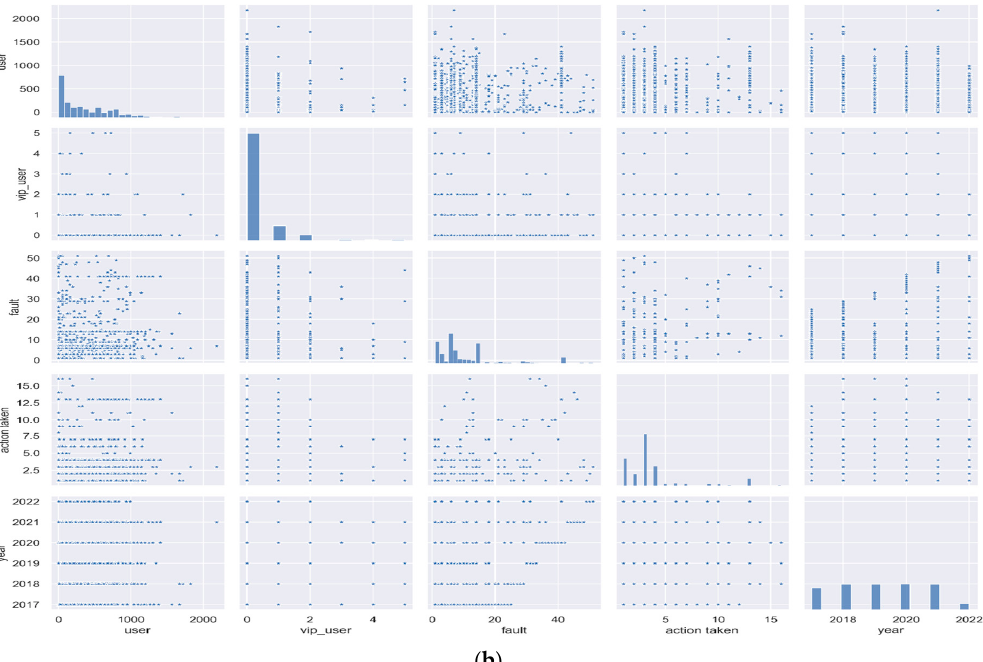
Figure 2. ( a ) Heat map of the data collected from Tabuk grid station; ( b ) Pair plot of the data collected from Tabuk grid station.